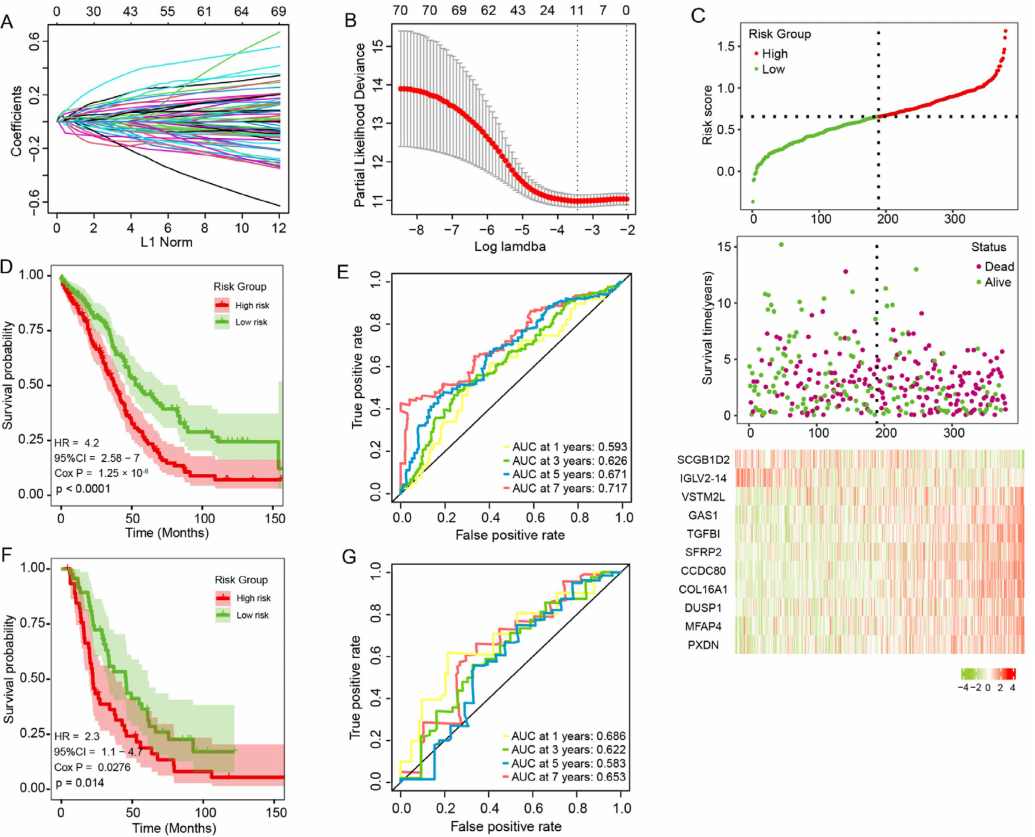
Figure 6. Construction and validation of the prognostic signature. ( A , B ) Eleven genes were identified by LASSO regression analysis. ( C ) Risk score distribution, survival status, and signature gene expression in the TCGA cohort. ( D ) The KM curves of the TCGA cohort. ( E ) The ROC curve of the TCGA cohort. ( F ) The KM curve of the ICGC cohort. ( G ) The ROC curve of the ICGC